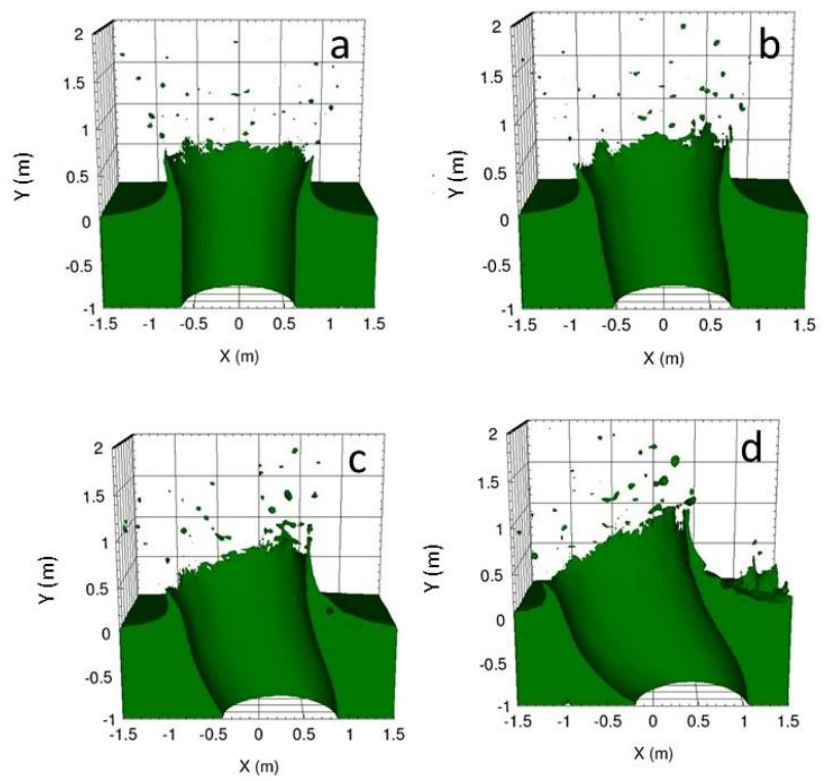
Figure 4. Mass density profiles of peat at t = 10 ms after the start of a simulated MQN interaction depositing 30 MJ/m on a trajectory inclined at ( a ) 0°, ( b ) 15°, ( c ) 30°, and ( d ) 45° from the vertical.